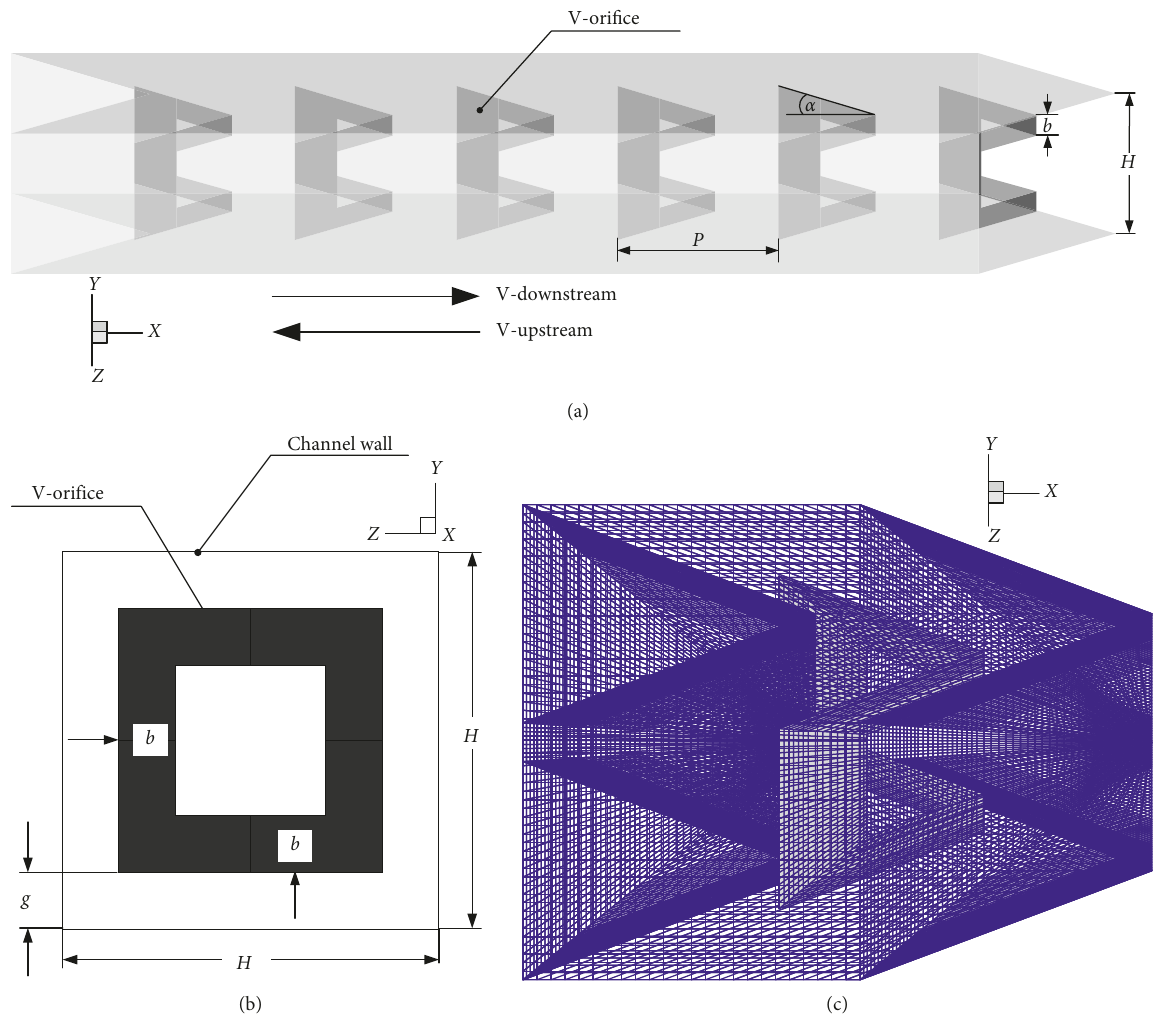
Figure 1: (a) Computational domain of the square channel heat exchanger installed with V-orifice. Numerical model in transverse plane (b) and with mesh